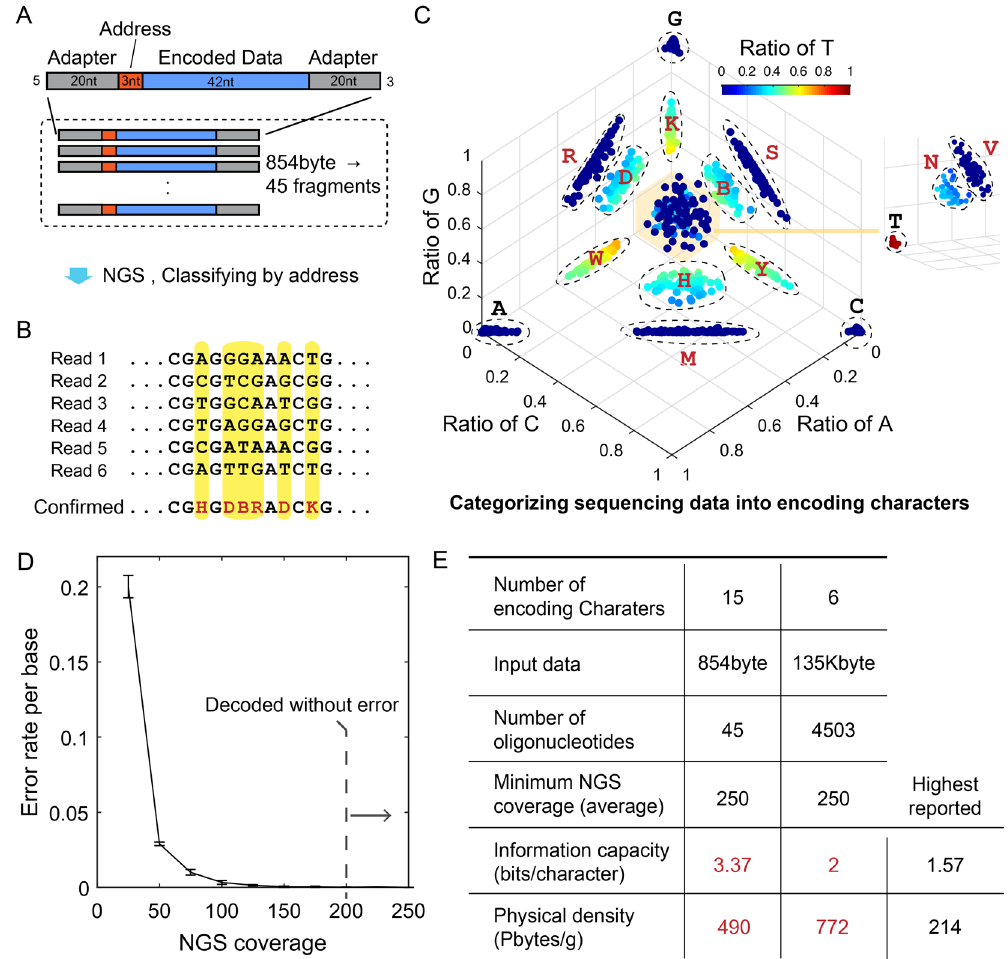
Figure 2. Structure and decoding result of the DNA-based data storage platform. We achieved the highest information capacity and physical density of DNA-based data storage. ( A ) Design structure of DNA fragments. ( B ) DNA fragments can be analyzed using NGS. After classification by address, degenerate bases can be decoded by examining the distribution of characters in the same position (yellow bar). ( C) Degenerate bases can be determined from the scatter plot of the ratio of bases in the same position. ( D ) The error rate of determined DNA bases in specific average coverage of the total fragments. The standard deviations (s.d.) were obtained by repeating the random sampling 10 times. The error bars represent s.d. ( E ) Summary of the experimental results. The information capacity is calculated from the input information in bits divided by the number of encoding characters (excluding that of adapter sites). We compared the results of our work with those of Erlich and Zielinski 10 , who previously reported the highest information capacity and physical density using pooled oligo synthesis and high-throughput sequencing data. The physical density is the ratio of the number of bytes encoded to the weight of the DNA library used to decode the